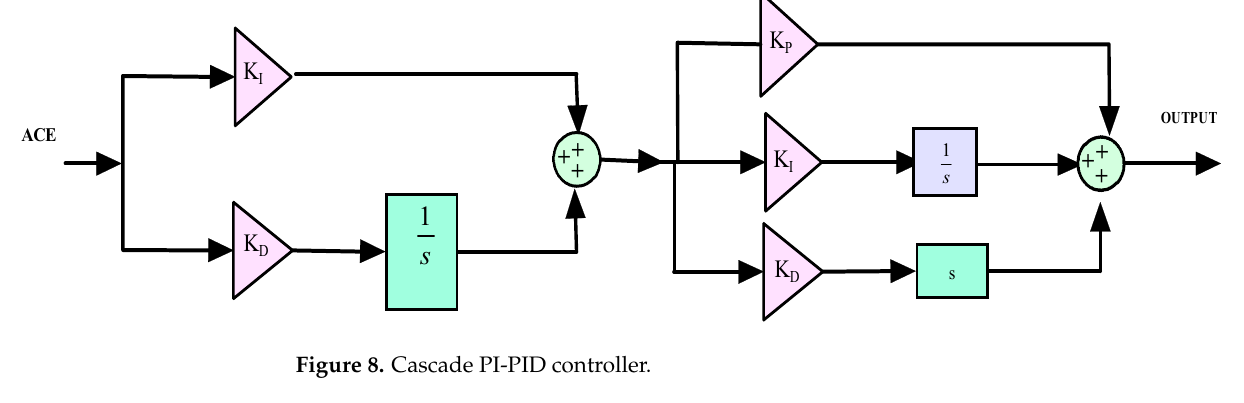
Figure 8. Cascade PI-PID controller.